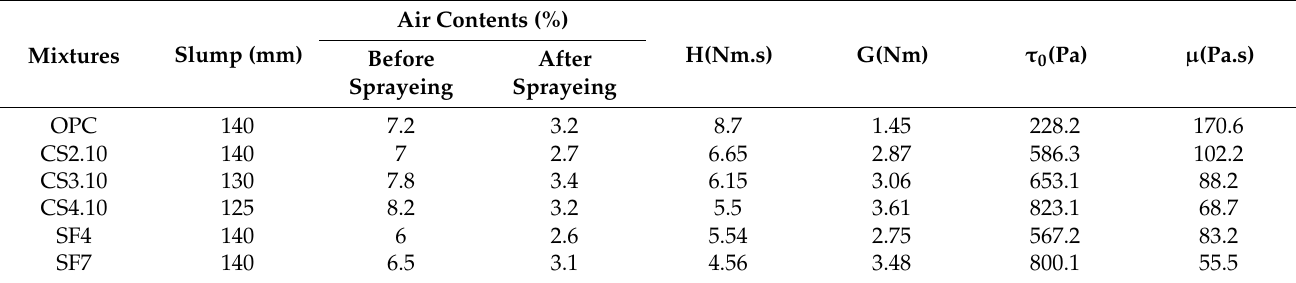
Table 3. Air volume, slump, and rheology characteristics according to the colloidal silica and silica fume mixing